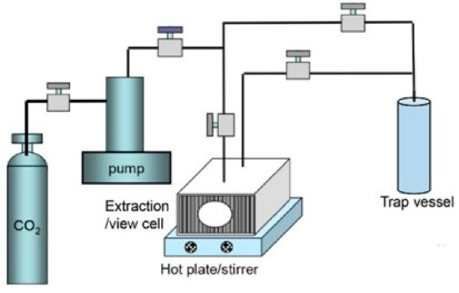
Figure 1. Schematic diagram of the SFE